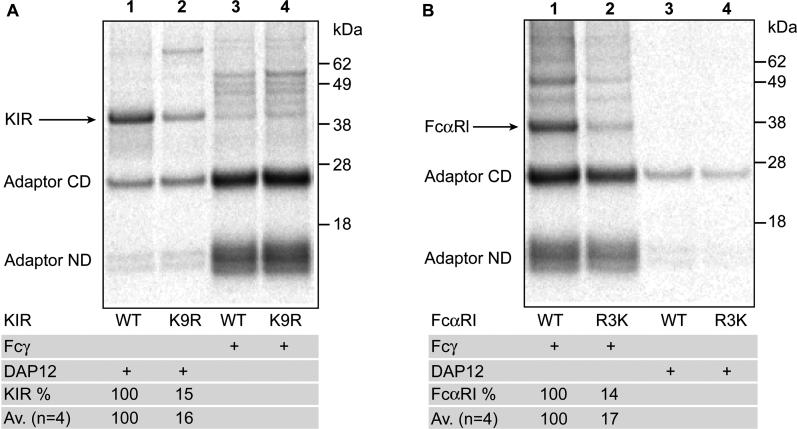
Mechanisms of Specificity I: Preference for a Particular Basic TM ResidueThe KIR receptor has a lysine close to the center of the TM domain (position 9), while the FcαRI receptor carries an arginine in the N-terminal segment of the TM domain (position 3).(A) Substitution of the KIR TM lysine by arginine (K9R) substantially reduced assembly with DAP12 (lanes 1 and 2). No assembly was observed with the Fcγ signaling dimer (lanes 3 and 4).(B) Substitution of the FcαRI receptor TM arginine by lysine (R3K) substantially reduced assembly with Fcγ (lanes 1 and 2). No assembly was observed with the DAP12 signaling dimer (lanes 3 and 4). SDS-PAGE was performed under nonreducing conditions. DAP12-associated KIR (A) or Fcγ-associated FcαRI (B) quantitations were normalized to total translation levels of these proteins. The images shown are representative of four experiments.